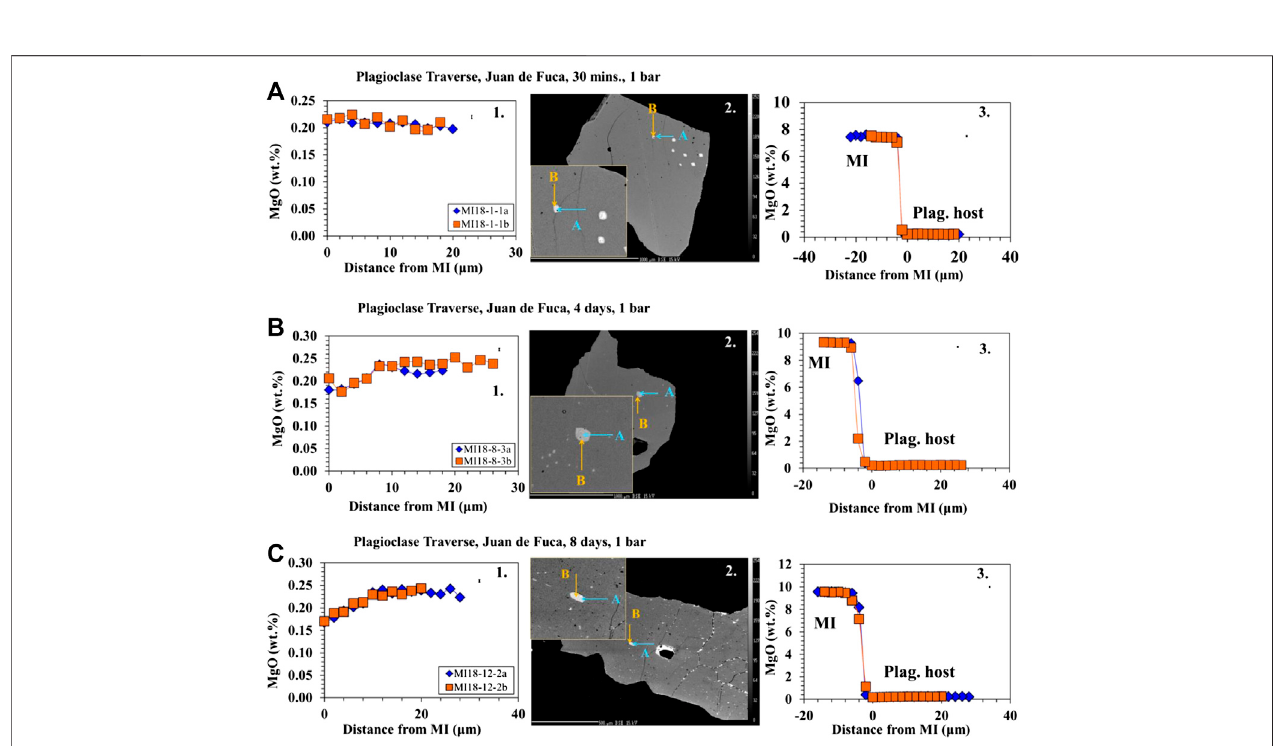
Frontiers in Earth Science |